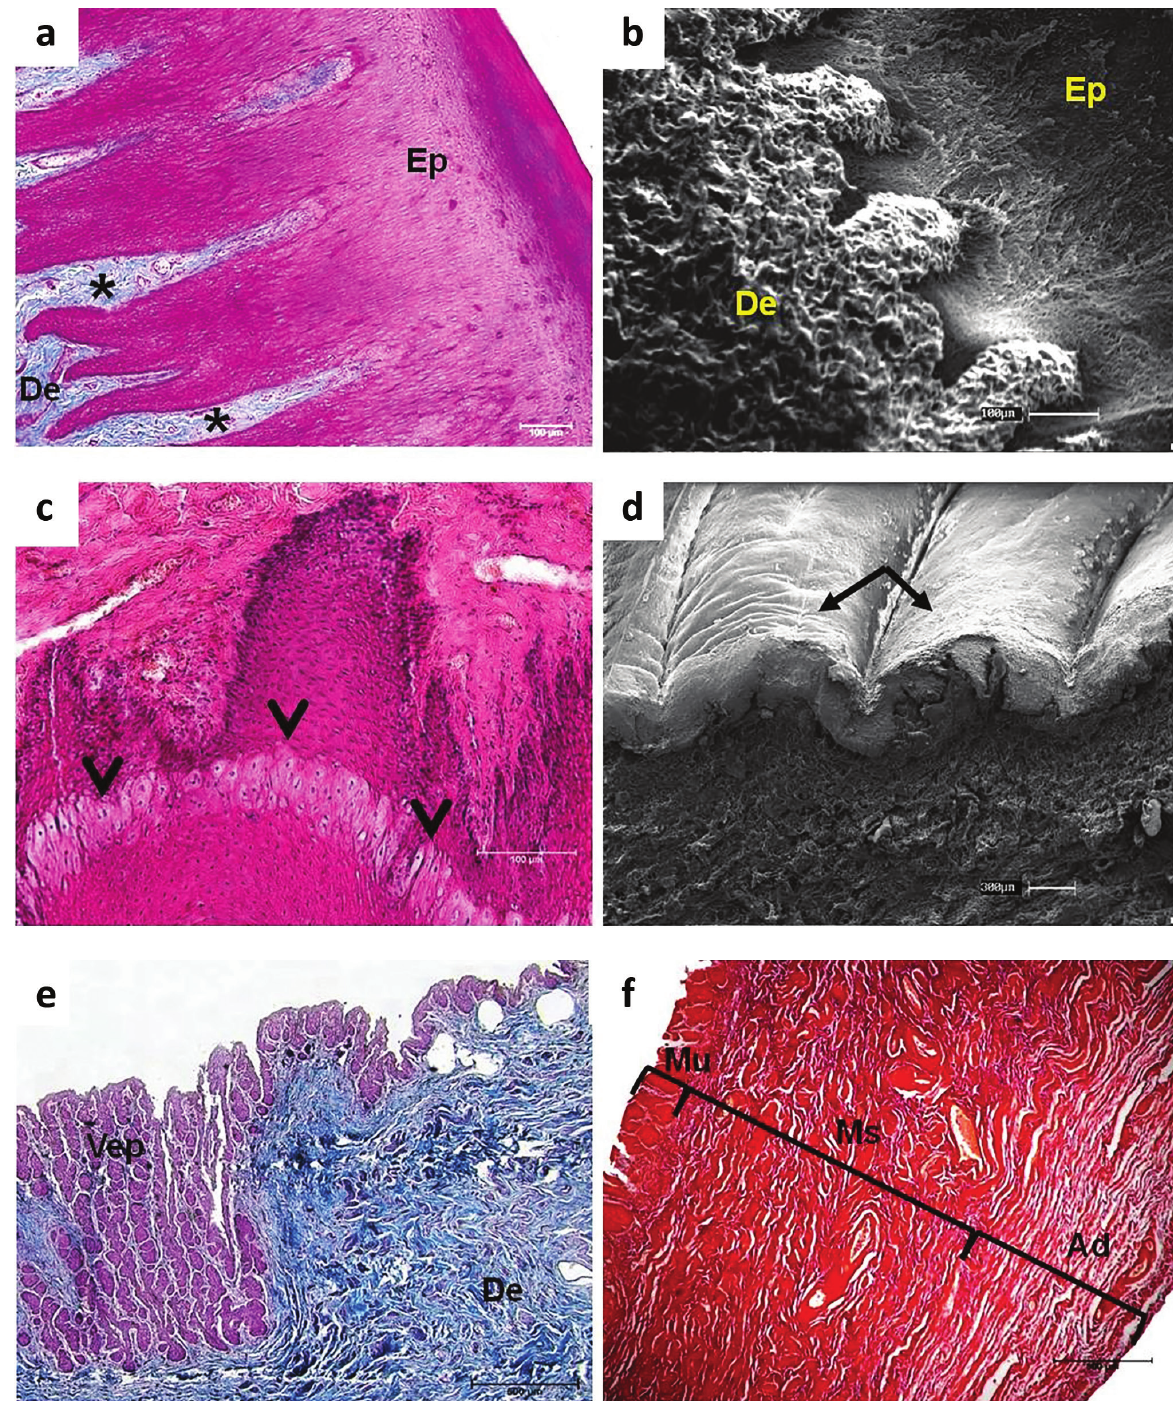
Figure 1 - Photomicrograph of genital slit (a, b) , vulva (c, d) , and vagina (e, f) of Sotalia guianensis . a, b. Dermal papillae (*) entering the epidermis. Epidermis (Ep) and dermis (De). a . 10x. Masson’s Trichrome (MT). b. Scanning electron photomicrograph. c. Differentiated cells (arrowheads) in the epidermal epithelium of the vulva. 20x. Hematoxylin-Eosin. d. Scanning electron photomicrograph. Presence of longitudinal folds of the mucosa of vulva (arrows). e. Vaginal epithelium (Vep) forming crypts in the dermis (De) underlying. 20x. MT. f. Mucosa (Mu), muscle (Ms) and adventitia (Ad) layers of the vagina. 4x.